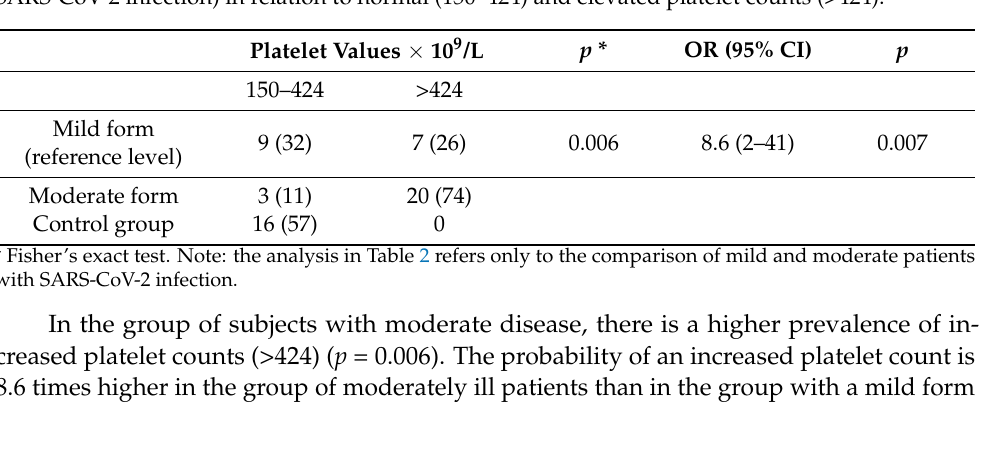
Table 4. Representation of the number (%) of subjects by groups (control, mild and moderate SARS-CoV-2 infection) in relation to normal (150–424) and elevated platelet counts